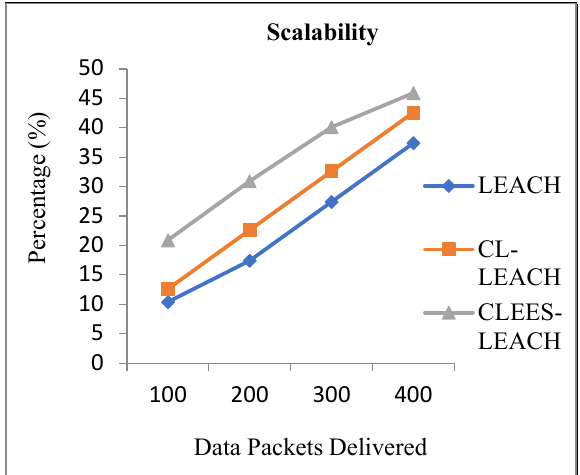
Figure 11. Scalability for existing protocol LEACH, CL-